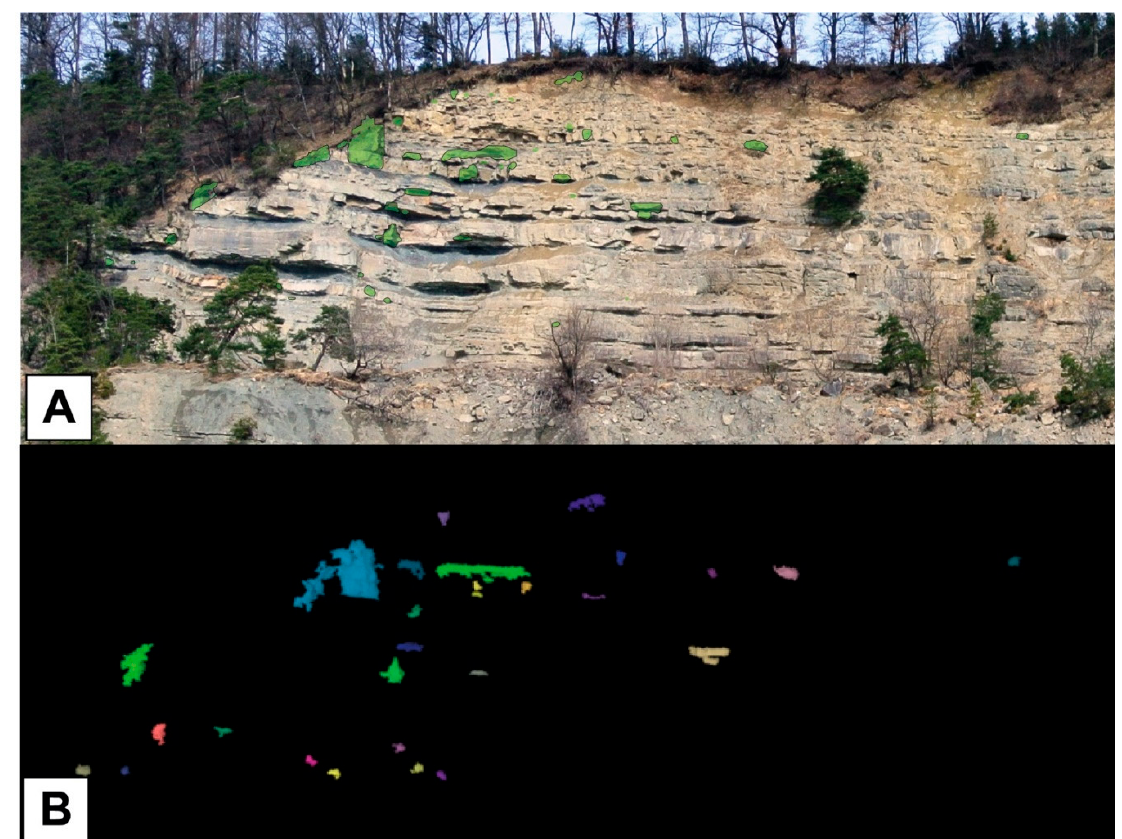
Figure 6. ( A ) An example of the location of identified rockfalls (green) based on field observations and picture analysis between two epochs (Fall 2012–Spring 2013). ( B ) Identified points belonging to different rockfall sources after using the rockfall source extraction function on the acquired point cloud between Fall 2012 and Spring 2013 with a terrestrial laser scanner in the same area. The segmentation of different individualized rockfall sources plotted with a different color.